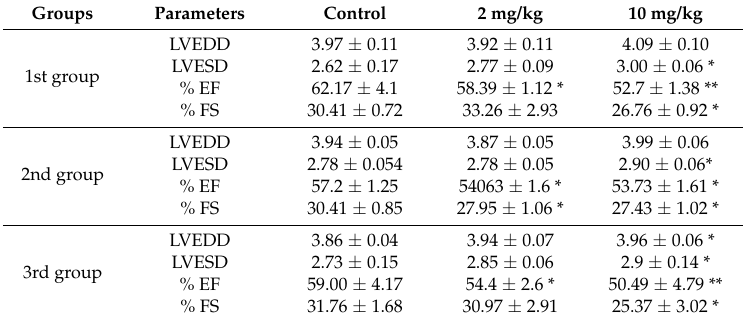
Table 1. Effect of Doxorubicin DOXO (2 or 10 mg/kg; i.p.) on left ventricular end diastolic diameter (LVEDD), left ventricular end systolic diameter (LVESD), ejection fraction (% EF), and fraction shortening (% FS) after a single administration (1st group), two administrations (2nd group), or three administrations (3rd group). Results were expressed as mean ± S.E.M. from 6